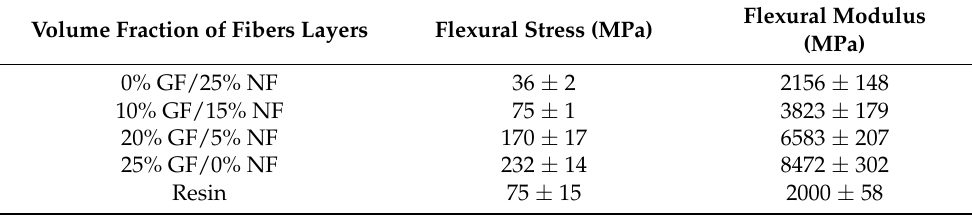
Table 4. Variation of flexural modulus and flexural stress vs. fibers fraction.